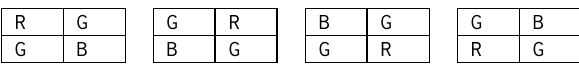
Figure 3. The four possible variations of the Bayer RGB